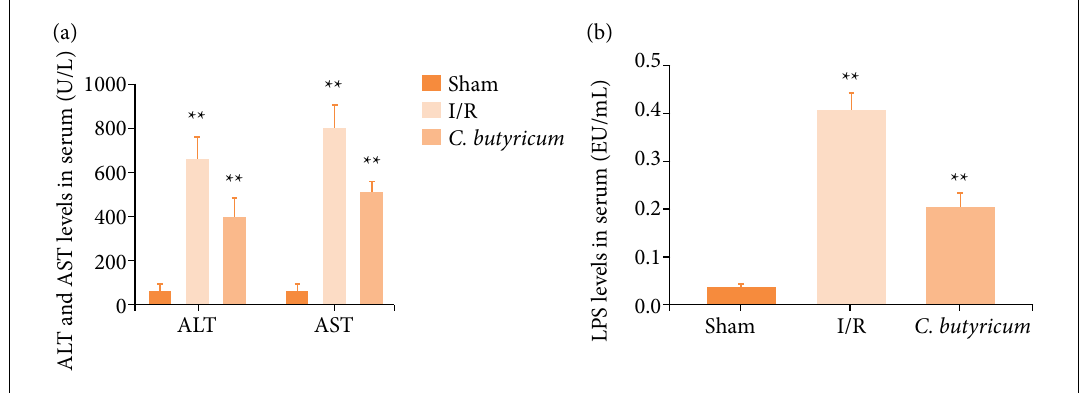
Figure 1 - The (a) ALT, AST and (b) LPS levels in plasma. ** p < 0.01 vs. the sham group;